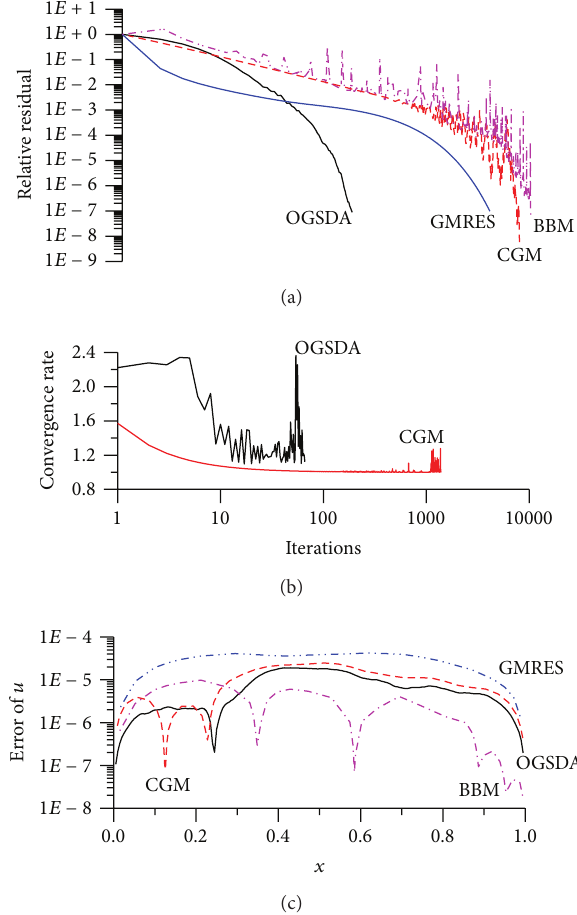
Figure 4: Example 3, comparing (a) relative residuals, (b) conver- gence rates, and (c) numerical errors of CGM, OGSDA, GMRES, and